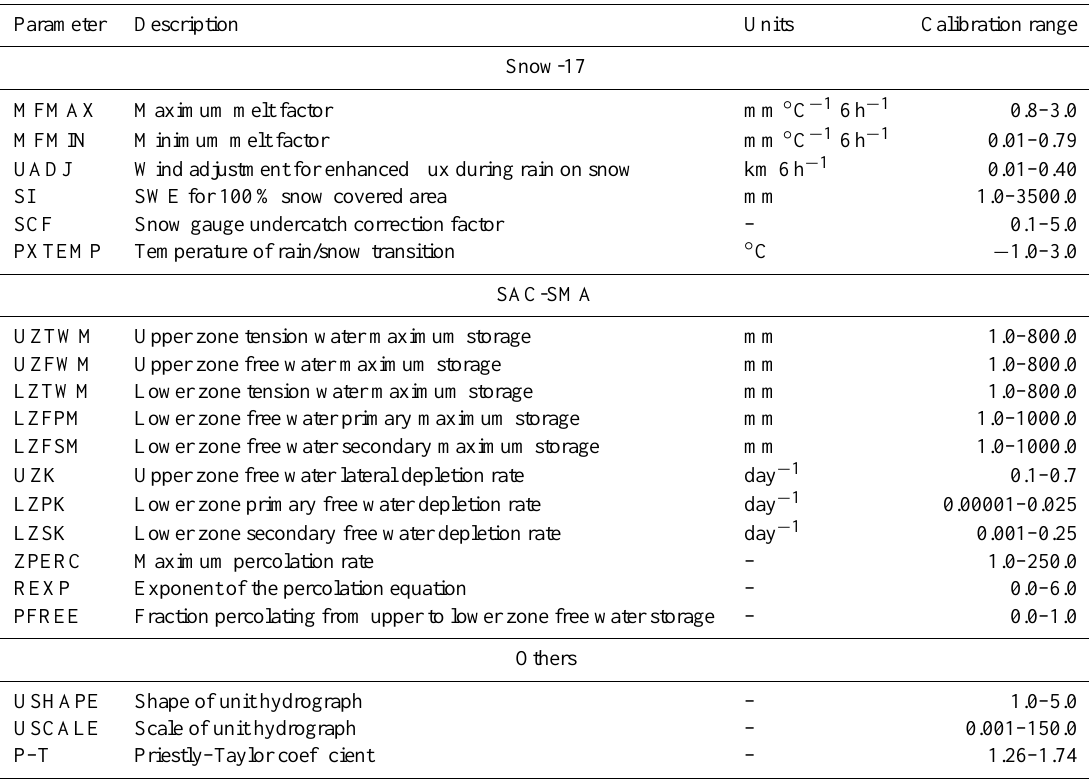
Table 1. Table describing all parameters calibrated and their bounds for calibration.